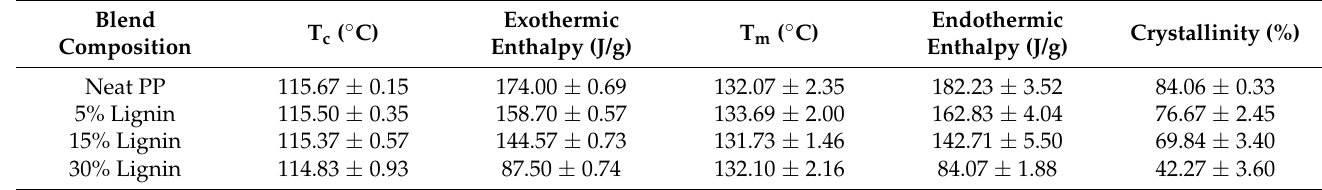
Table 2. DSC Test Results.